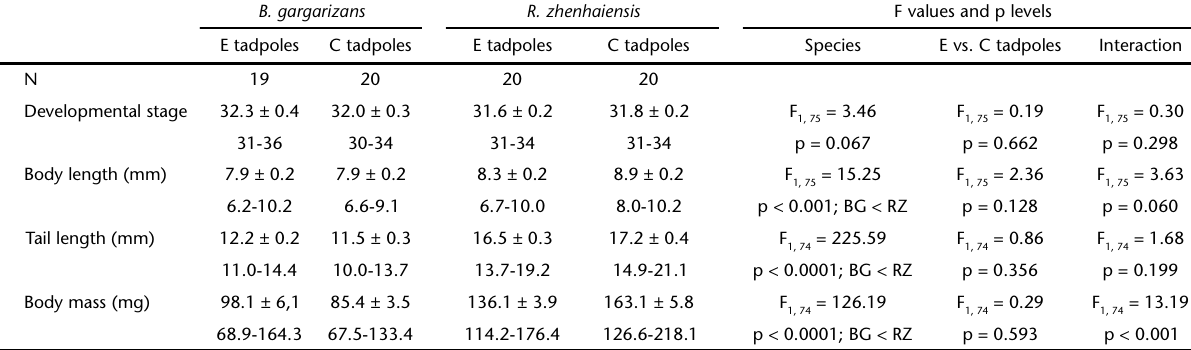
Table I. Descriptive statistics, expressed as mean ± SE and range, for developmental stage and morphological traits (body length, tail length and body mass) of B. gargarizans and R. zhenhaiensis tadpoles used to examine the effect of tail loss on swimming performance and survival rate. F values of two-way ANOVA (for developmental stages and body length) and ANCOVA (for tail length and body mass with body length as the